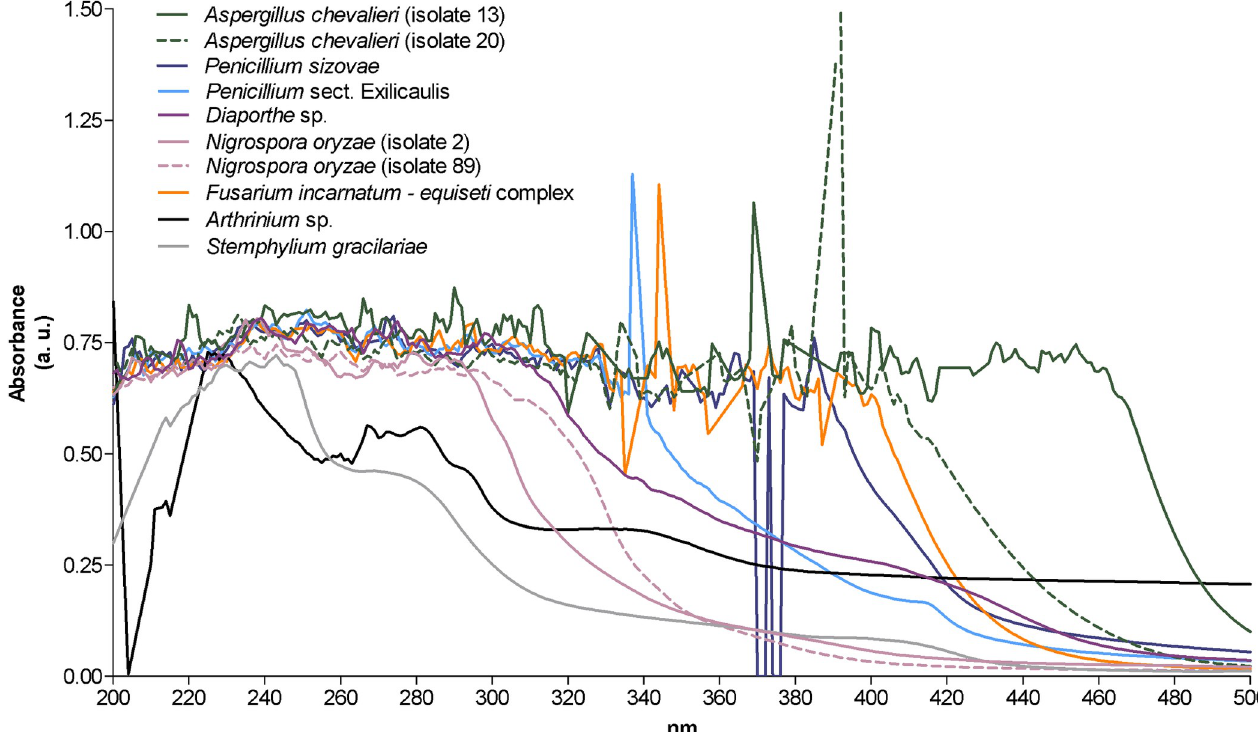
Fig 7. UV–Vis absorption spectra (200–500 nm) of the crude extracts obtained from marine endophytic fungi associated with Halopteris scoparia .